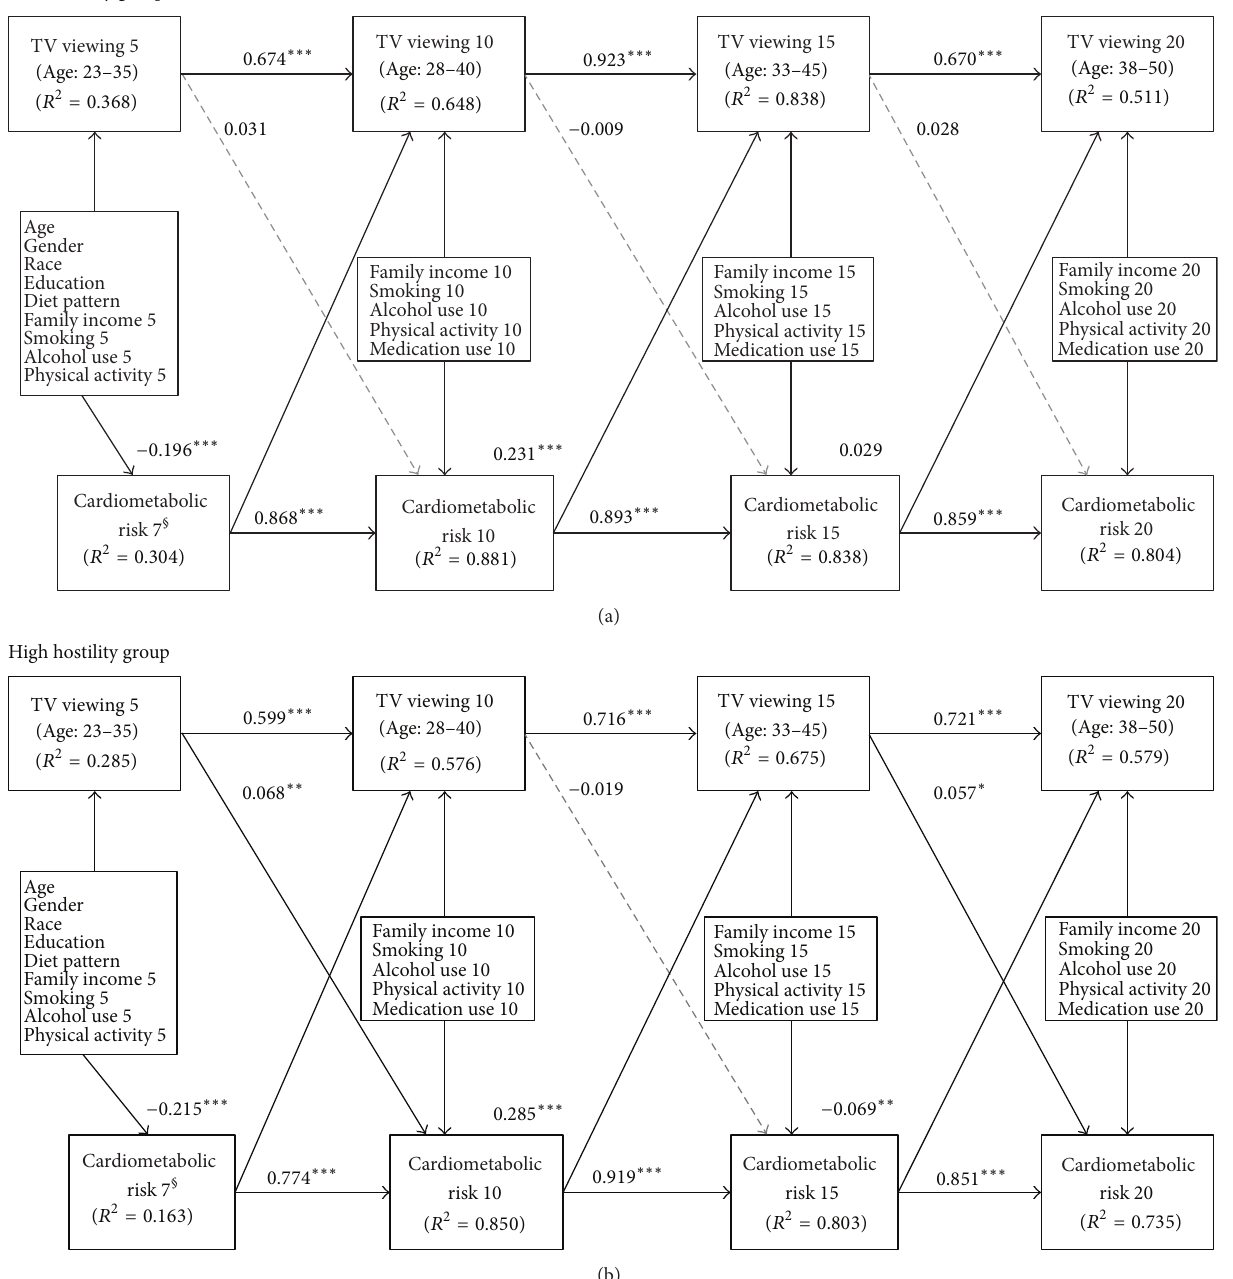
Figure 2: Two cross-lagged panel models showing the associations between duration of TV viewing and cardiometabolic risk are stronger for people with high hostility relative to those with low levels of hostility. Regression weights are standardized. R 2 represents the estimated proportion of the assumed underlying continuous variable explained by the model. § Cardiometabolic risk 7 is a surrogate of cardiometabolic risk 5. ∗ 𝑃 < 0.05 ; ∗∗ 𝑃 < 0.01 ; ∗∗∗ 𝑃 < 0.001